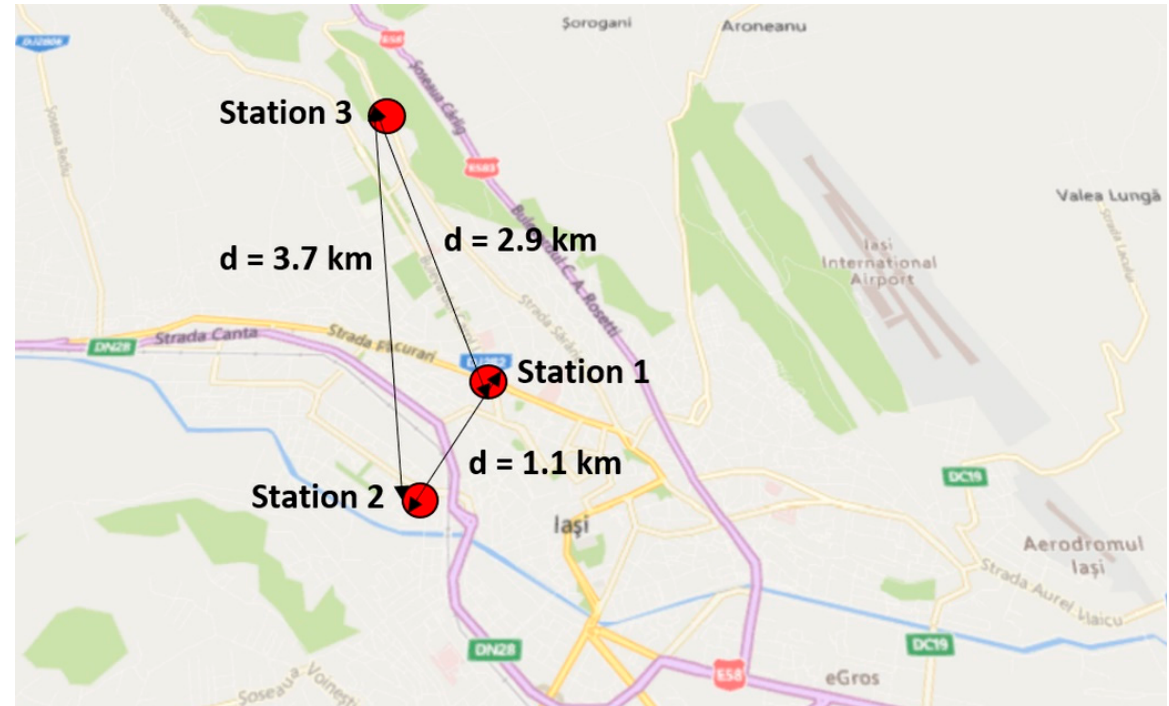
Figure 12. Positions of the three seismic stations in Iasi, as well as the distance between them.